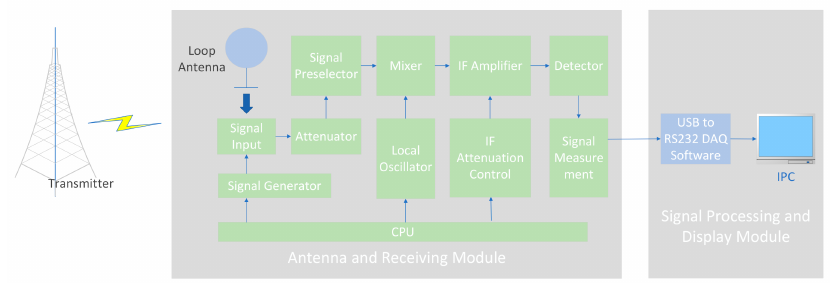
Figure 4. Experimental equipment for annular eclipse